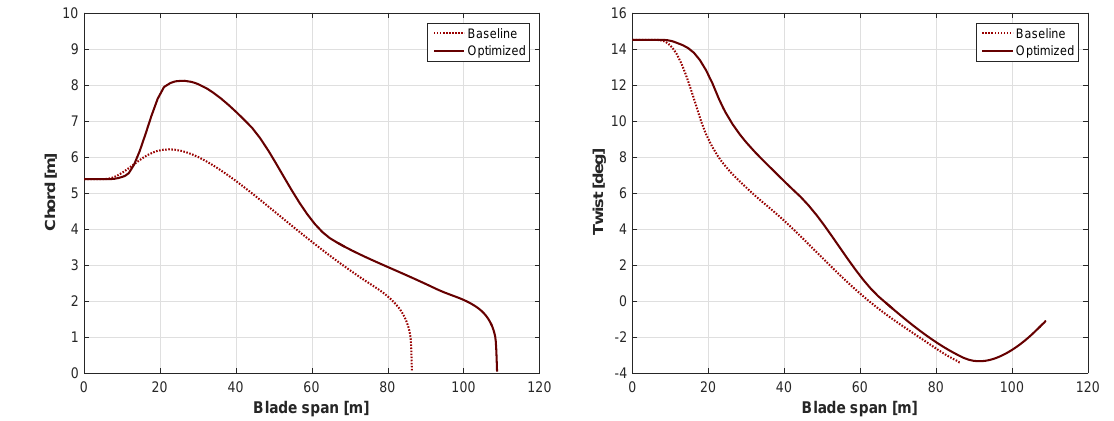
Figure 8. Chord and twist distributions of the baseline and the optimized 10MW wind turbine blades.